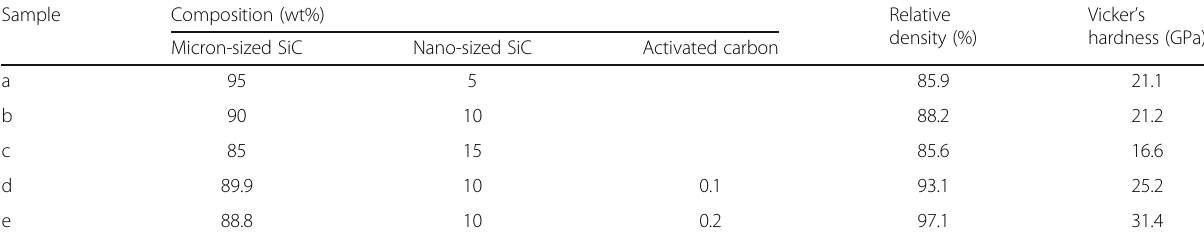
Table 2 Composition of micron-sized SiC, nano-sized Si-SiC composite particle, and activated carbon for preparing sintered SiC pellets, and their relative densities and Vicker ’ s hardness (sintering temp. 1800 °C, holding time 1 min, pressure 80 MPa)